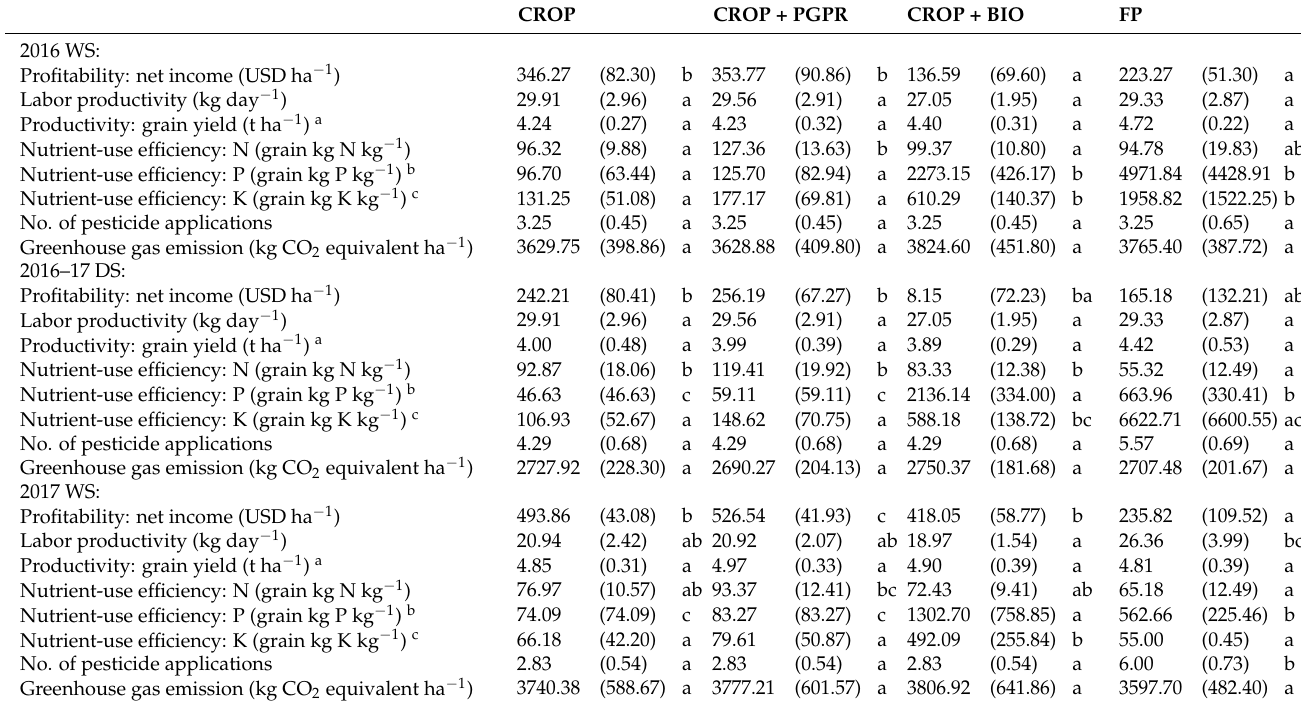
Table 5. Key SRP performance indicators (mean values followed by standard error in parenthesis) of rice production across four field trial treatments over three seasons.